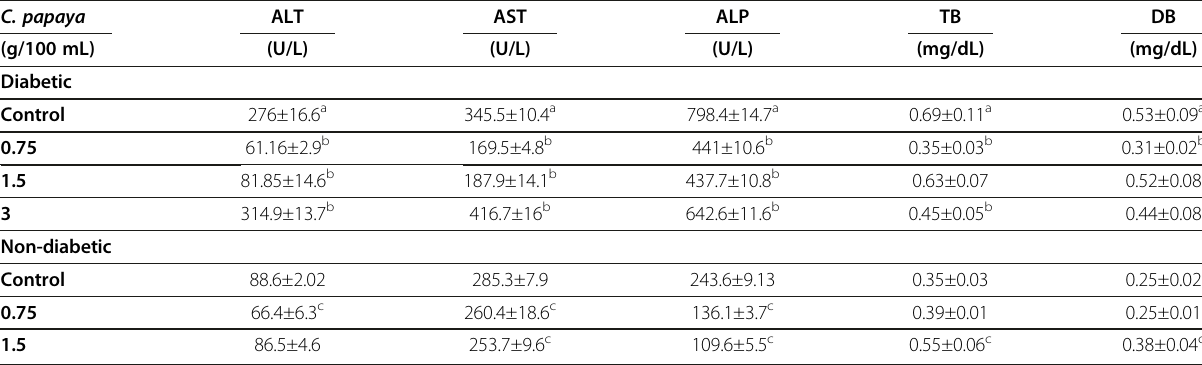
Table 3 Effect of aqueous extract of C. papaya leaf on the hepatic profile in diabetic and non-diabetic rats C. papaya